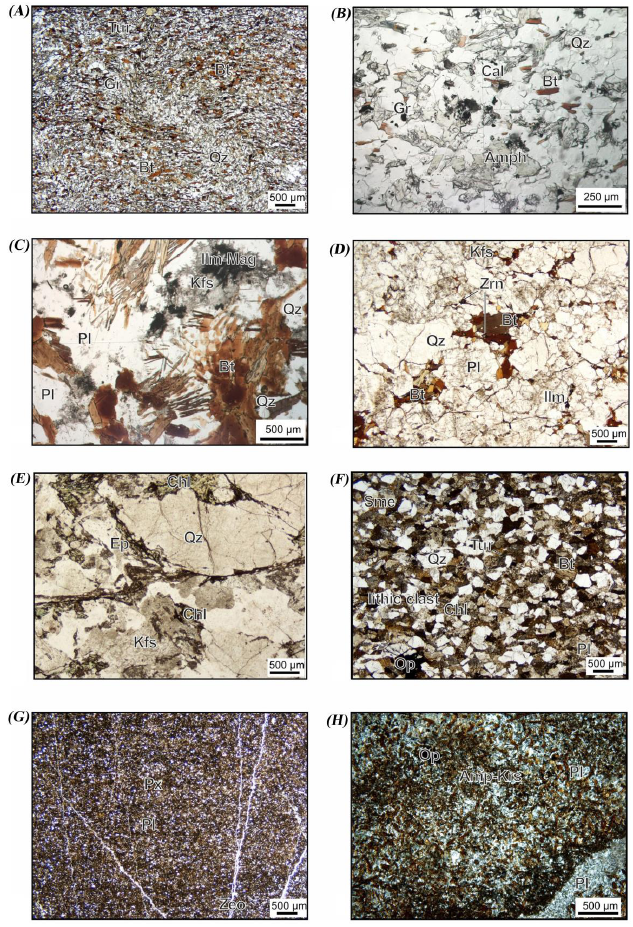
Figure 14. Microphotographs of typical lithological units in the study area. ( A ) Microphotograph of 14 fine graded biotite-rich quartzitic schist from the low-grade-Priestley Formation, Eisenhower Range; main minerals along the folded foliation are biotite and quartz with minor tourmaline, graphite and white mica. ( B ) Microphotograph of banded biotite quartzitic schist from the low-medium-grade Priestley Schist, Boomerang Glacier, Priestley Glacier area; main minerals are represented by quartz, biotite, amphibole with minor k-feldspar, plagioclase, white mica, graphite and secondary calcite. ( C ) Microphotograph of coarse-grained banded biotite-gneiss from migmatitic gneisses, Mt. Dick- ason, western Priestley Glacier area; typical mineralogy includes quartz, plagioclase, k-feldspar (occasionally saussuritic), large biotite laths and opaque minerals. ( D ) Microphotograph of medium to fine-grained granite-granodiorite from the Granite Harbour Intrusives, Mt. Baxter, Priestley Glacier area; main minerals are biotite, quartz, plagioclase and minor k-feldspar, opaque minerals. ( E ) Mi- crophotograph of partially recrystallized and deformed coarse-grained granite from the Granite Harbour Intrusives, Priestley Glacier area; main minerals are quartz, saussurritic k-feldspar, chlo- rite and minor epidote. ( F ) Microphotograph of coarse-grained subarkose to lithic subarkose from the Beacon Supergroup, Deep Freeze Range, Mt. Levick, Priestley Glacier area; main components are quartz, feldspars, micas, chlorite, lithic grains, opaque minerals and secondary smectite. ( G ) Mi- crophotograph of tuffaceous siltstone with volcanic ashes, plagioclse, lithic fragments, oxide and altered glass, Mesa Range area; veinlets are filled by zeolites. ( H ) Microphotograph of alkaline-basalt from dykes swarm from the McMurdo Igneous Complex, Priestley Glacier area; main minerals are brown amphibole (kaesrutitic), plagioclase (microphenocrystals) and minor opaque (magnetite) and olivine. Abbreviation: Tur = tourmaline, Gr = graphite, Bt = biotite, Qz = quartz, Cal = calcite, Amph = amphibole, Kfs = k-feldspar, Ilm-mag: Ilmenite-magnetite, Pl = plagioclase, Zrn = zircon, Ilm = Ilmenite, Ep = epidote, Chl = chlorite, Sme = smectite, Op = opaque minerals, Px = pyroxene, Zeo = zeolite, Amp-Krs = amphibole kaesrutitic (adapted from Whitney and Evans